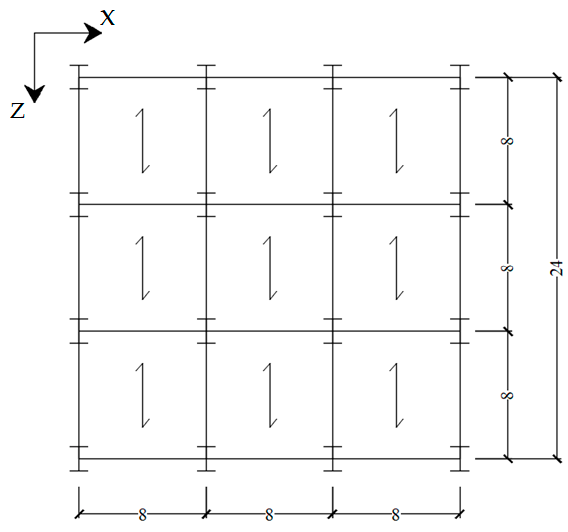
Table 1. Dead and live loads ( n : number of stories; G: dead loads; Q: live loads).